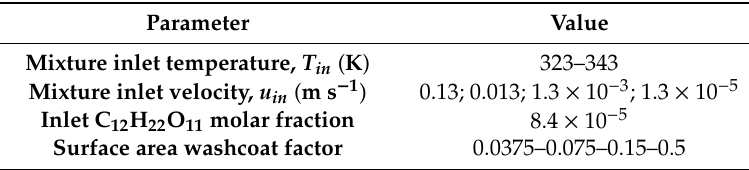
Table 4. Inlet parameter